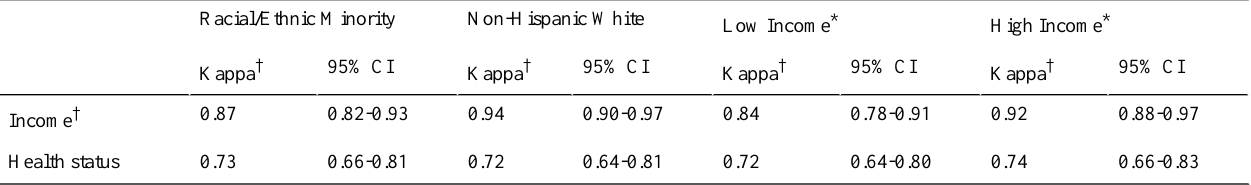
Table 3. Internet–telephone reliabilities of ordinal variables by race/ethnicity and income